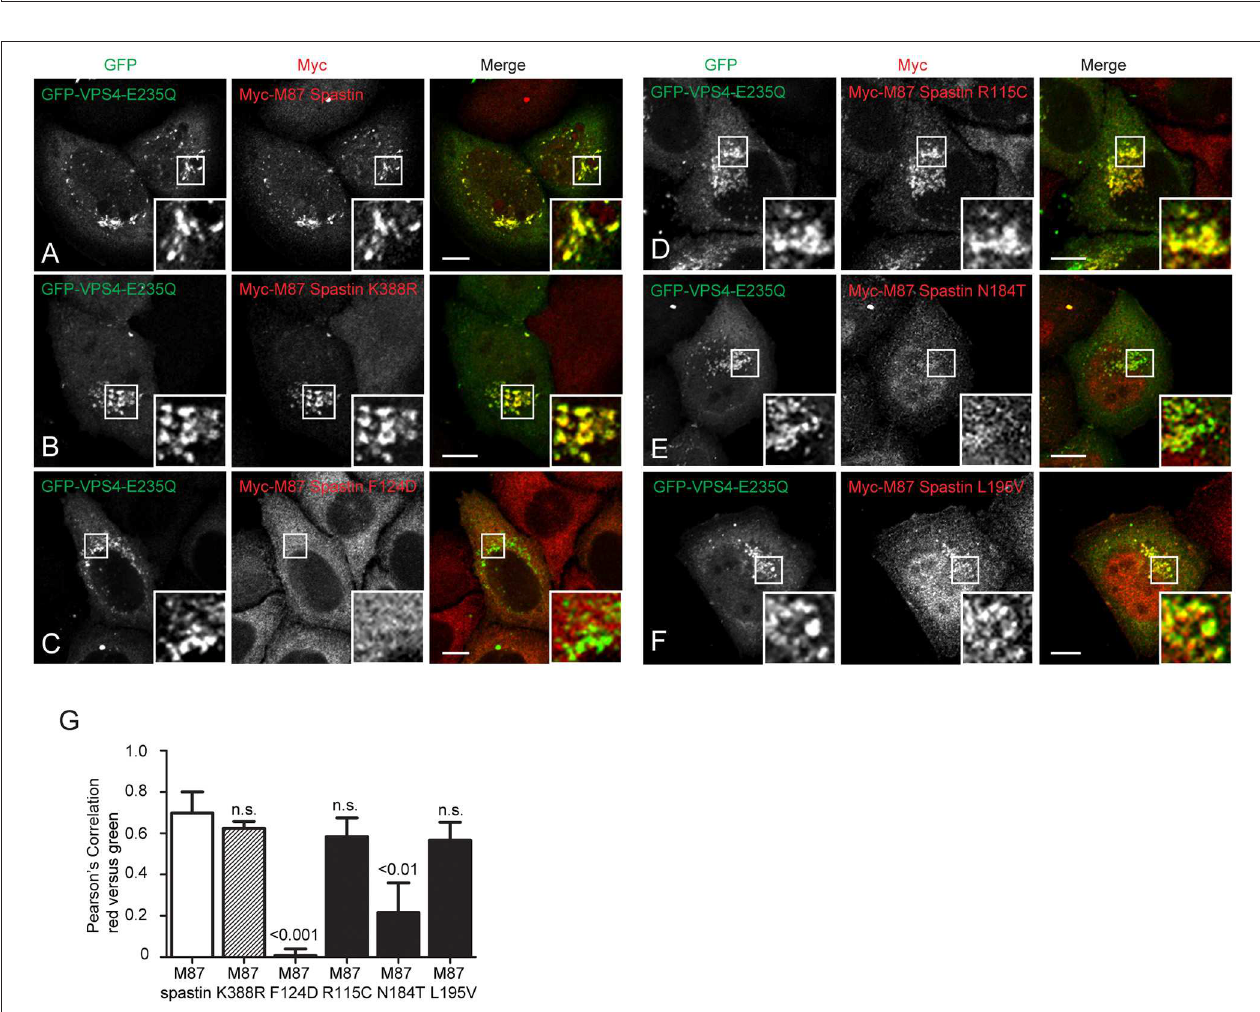
FIGURE 3 | cells per condition. The mean and SEM of the percentage of cells with largest lysosome > 1.8 µ m is shown ( n = 4 biological repeats). P -values were calculated by one-way ANOVA with Bonferroni’s post hoc multiple comparison test. In addition to the p -values shown, the M87 wild-type KD value was significantly different from all other KD values with a significance of at least p < 0.01. (G) Wild-type HeLa cells or HeLa cells expressing the siRNA-resistant spastin constructs indicated were subjected to mock transfection or siRNA-mediated KD of endogenous spastin. Electron micrographs of representative endolysosomal structures are shown. Note the presence of highly abnormal structures in each of the cells expressing mutant spastin. Scale bar = 500nm.